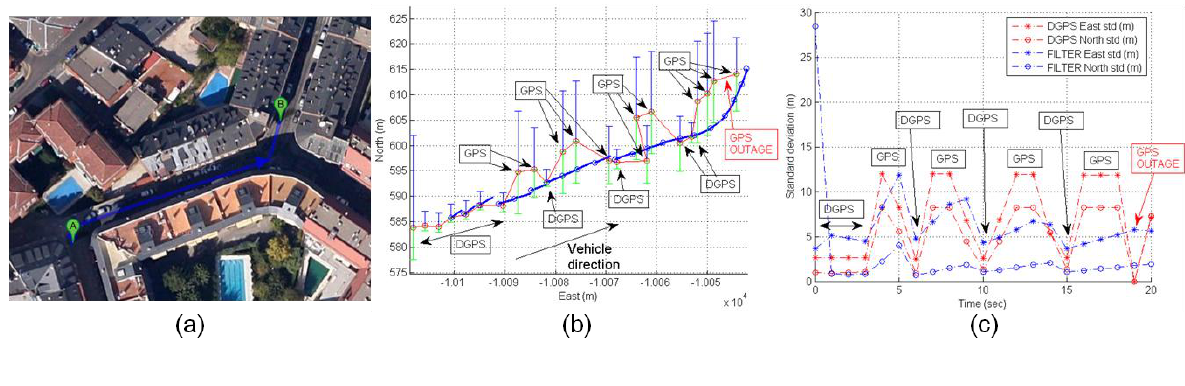
Figure 24. ( a ) Roundabout with DGPS groundtruth. ( b ) DGPS trajectory (red) with deactivation and activation and UKF filter solution (blue). ( c ) Detail of UKF filter solution without 15 seconds of DGPS solution. ( d ) Time-domain standard deviation